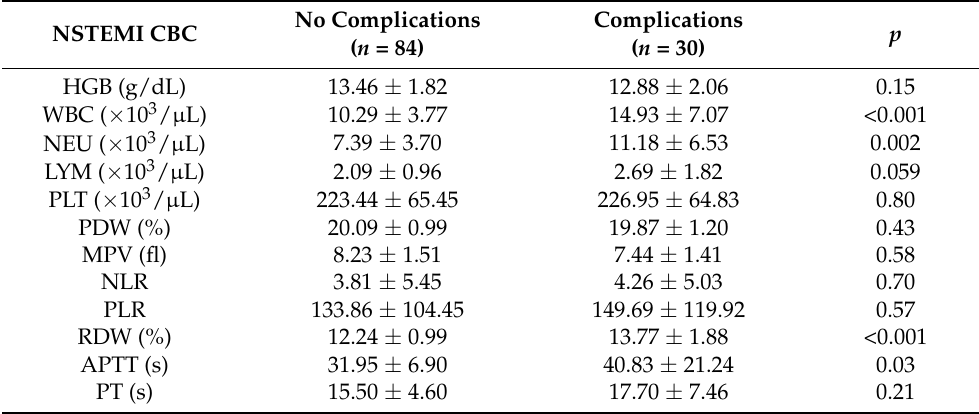
Table 5. Hematological and coagulation parameters of the groups with/without in-hospital compli- cations in NSTEMI patients.